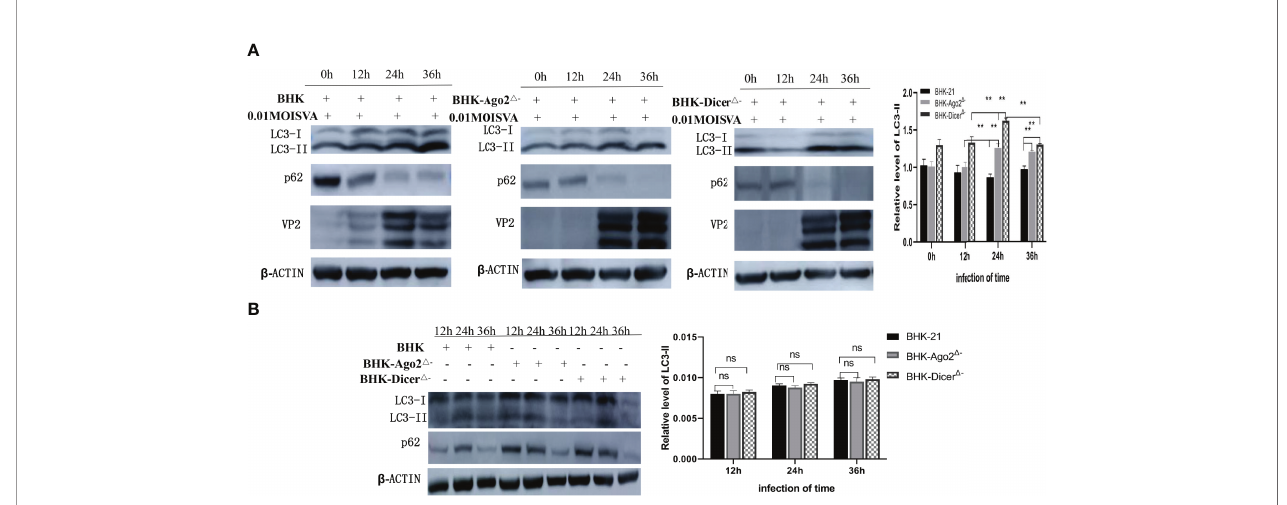
FIGURE 3 | Autophagy promotes the proliferation of SVA inknockout cells. (A) Western blot analysis of LC3, p62, VP2, and b -actin levelsin transfectedBHK-21 cells and knockout cellsthat were mock-infected with SVA at an MOI = 0.01. The relatative level of LC3-II from three independent experiments were shown(ns, nosigni fi cant difference; **, P < 0.01). ImageJ was used to quantify the level of protein. (B) Western blot analysisof LC3, p62, and b -actin levelsin transfected BHK-21 cells and knockout cells. The relative level of LC3-II from three independent experiments were shown(ns, nosigni fi cant difference).ImageJ was used to quantify thelevel of